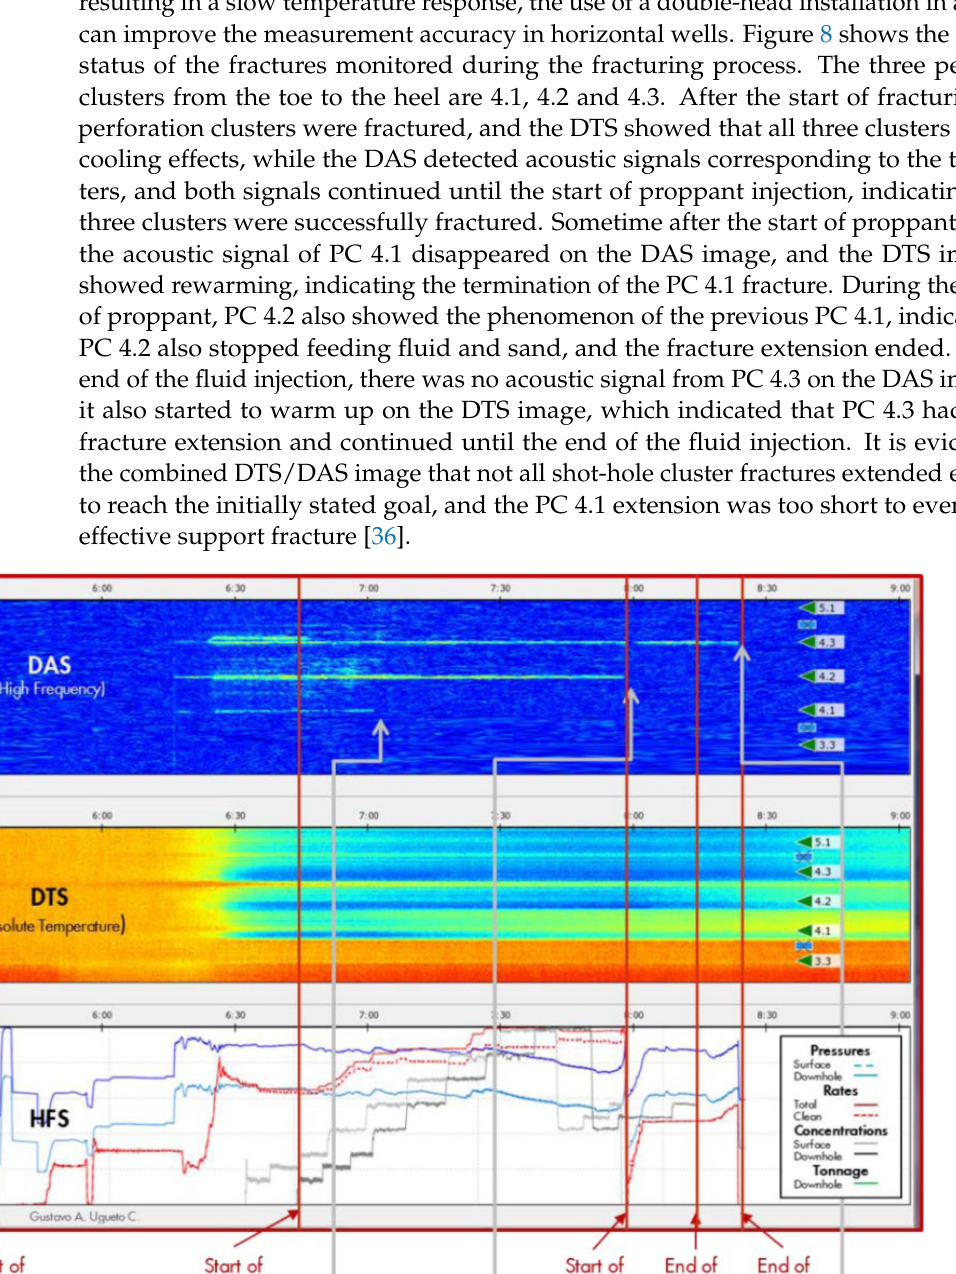
integrated microseismic data to modify the wellbore-temperature model to improve the accuracy of the calculation results. Li et al. [39], made a homemade set of physical simulation experiments based on temperature profiles of horizontal wells fractured in DTS gas reservoirs, and input differ- ent proppant types to set three fracture-inflow-capacity patterns, homogeneous fracture, increasing inflow capacity in sequence and decreasing inflow capacity in sequence, and plotted temperature profiles from the heel section to finger end based on the experimental results. They concluded that temperature drop at the fracture is positively correlated with fracture-inflow capacity. Combined with the fracture inflow, the fracture-inflow capacity can be estimated to identify and locate high-yield fractures, which provides a theoretical basis and physical experimental foundation for fracture diagnosis. Differences in both fracture-inflow capacity and geometry can lead to uneven distribution of the injected fluid, but such differences have little effect on the retort process, meaning that it is difficult to quantify the height and length of fractures from DTS retort data [40]. However, in 2020 Sun et al. developed the thermally embedded discrete fracture model (TEDFM) and the integrated multiple data assimilation (ESMDA) inversion model, which can be used to deal with the thermal behavior of complex fracture networks in multiphase flows, and the hydraulic fracture half-length, height and inflow capacity can be obtained based on the matching of DTS data history [41]. However, there are unavoidable limitations when